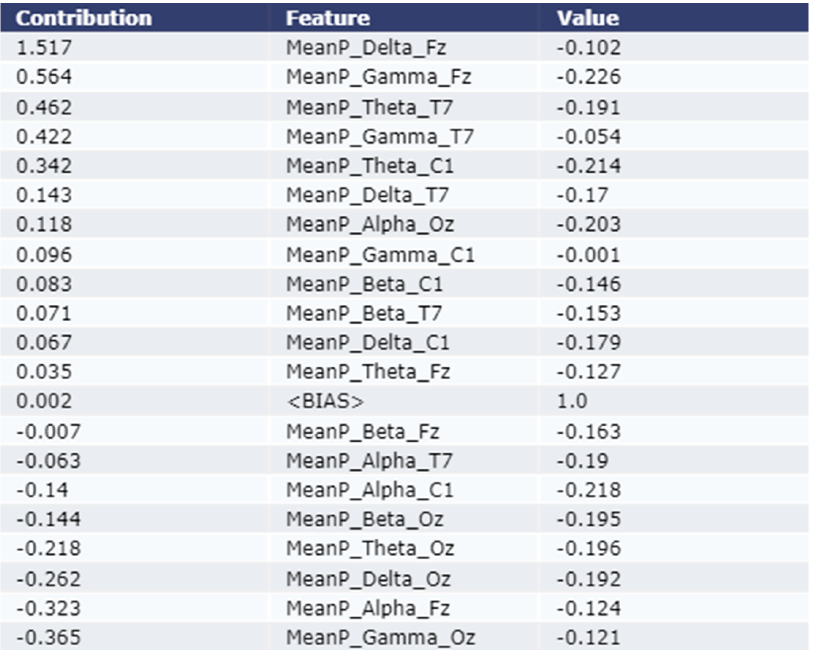
Figure 5. Explanation of the local contribution of EEG features through the Eli5 model in classifying a single test instance (predicted class = Stroke) using the LightGBM model. The importance of the features is denoted by positive contribution.